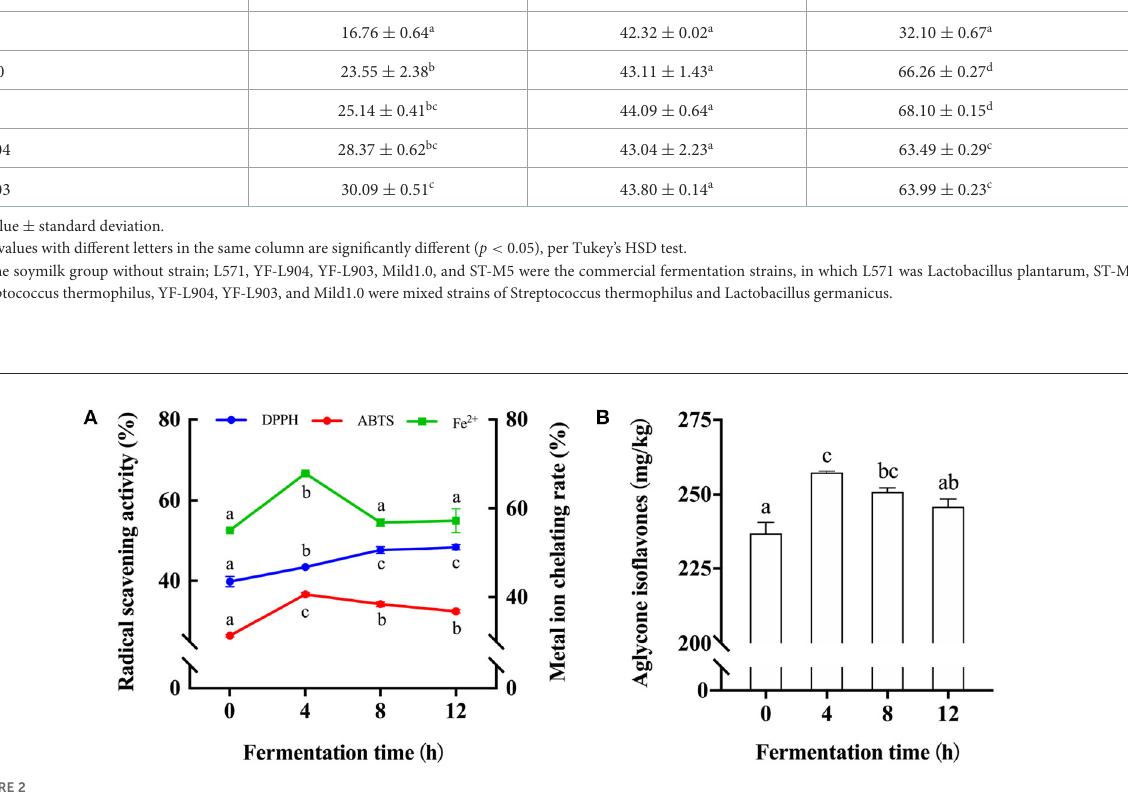
TABLE 1 Antioxidant activity of soymilk fermented by different commercial lactic acid bacteria. FSM with different lactic acid